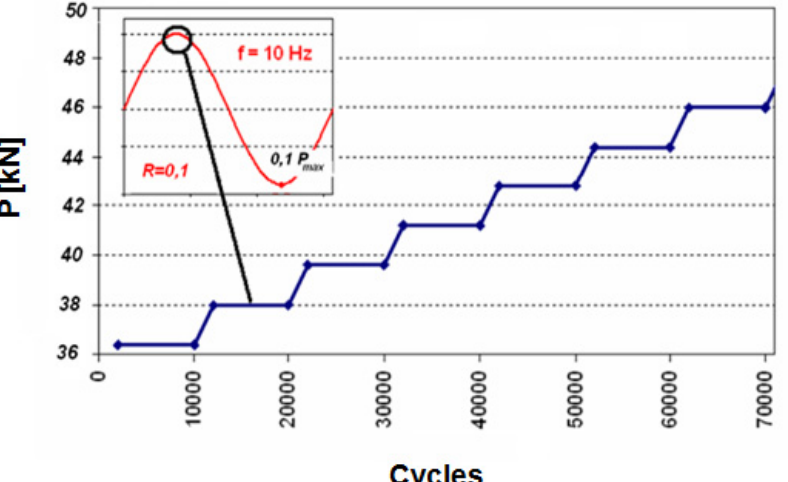
Figure 14: Load history imposed during fatigue test.